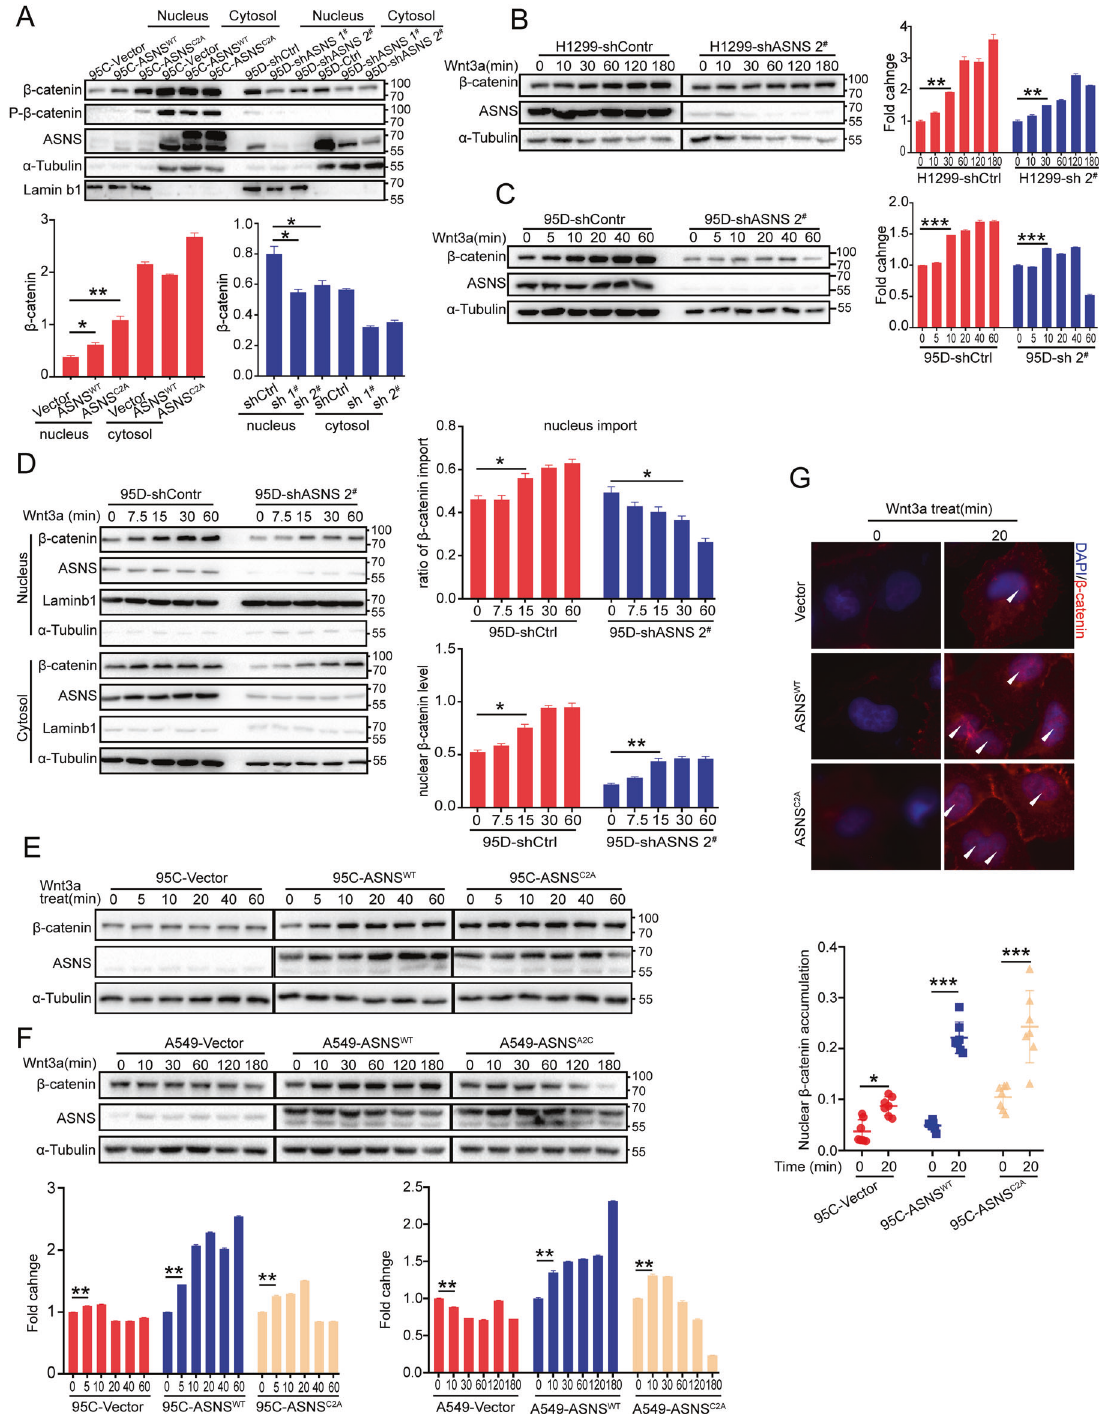
Fig. 5 ASNS promotes β -catenin accumulation and translocation into nucleus. A Cell components of cytosol and nucleus were segregated by the Nuclear and Cytoplasmic Extraction Reagents. Lamin b1, a marker of nuclear component, α -tubulin, a marker of cytosolic component; levels of nuclear β -catenin were normalized to Laminb1, and levels of cytosolic β -catenin were normalized to Tubulin. Wnt 3a was a special activator for Wnt pathway and was always used to drive Wnt cascade in vitro. The whole-cell β -catenin accumulation was detected by western blot when wnt3a treated in cell lines of H1299 ( B ), 95D ( C ), 95C ( E ), and A549 ( F ). All levels of β -catenin in gradient time after wnt3a treatment were normalized to initial levels of β -catenin (0 min). Furthermore, the translocation of β -catenin into nucleus was detected by western blot ( D ) and immuno fl uorescence ( G ). The different protein levels between groups were tested by Student ’ s t test. Error bars were expressed as mean ± S.D. P <0.05 is signi fi cant statistic difference, * p <0.05, ** p < 0.01, *** p <0.001. Representative images from three independent experiments are shown.